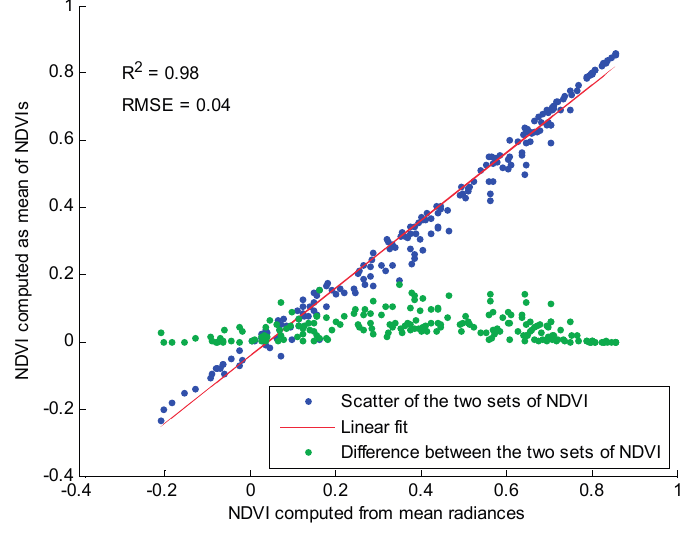
Figure 5. A comparison between two ways of averaging NDVI. Blue dots show a scatter plot of NDVI computed from average high resolution radiances versus NDVI computed as an average of high resolution NDVIs. The green dots show the difference between the two sets of